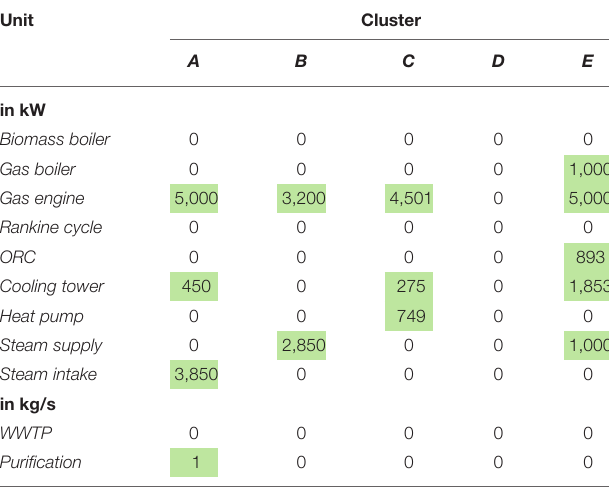
TABLE 2 | Utility unit sizing in each cluster (total cost